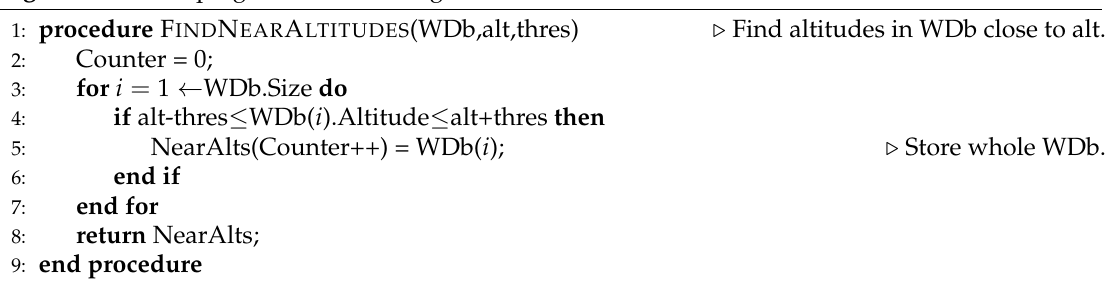
Algorithm 2 Grouping near altitudes algorithm.